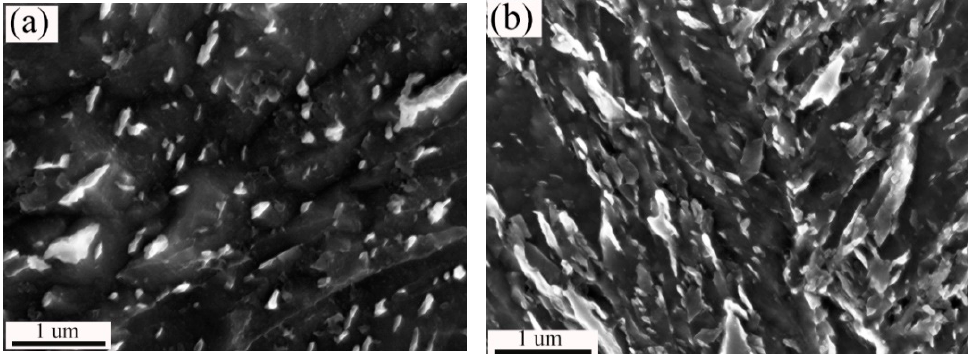
Figure 3. SEM micrographs of the matrix, ( a ) and the carburised layer, ( b ) heated to 550 °C and quickly cooled (15 °C/s) to room temperature.